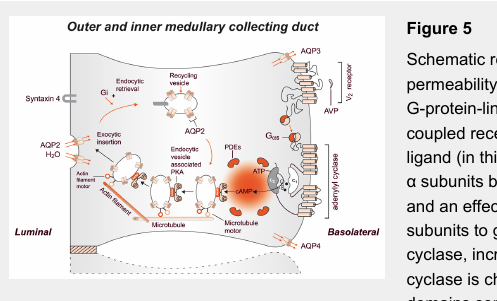
Schematic representation of the effect of vasopressin (AVP) to increase water permeability in the principal cells of the collecting duct. AVP is bound to the V 2 receptor (a G-protein-linked receptor) on the basolateral membrane. The basic process of G-protein- coupled receptor signalling consists of three steps: a hepta-helical receptor that detects a ligand (in this case, AVP) in the extracellular milieu, a G-protein (G αs ) that dissociates into α subunits bound to GTP and βγ subunits after interaction with the ligand-bound receptor, and an effector (in this case, adenylyl cyclase) that interacts with dissociated G-protein subunits to generate small-molecule second messengers. AVP activates adenylyl cyclase, increasing the intracellular concentration of cAMP. The topology of adenylyl cyclase is characterised by two tandem repeats of six hydrophobic transmembrane domains separated by a large cytoplasmic loop and terminates in a large intracellular tail. The dimeric structure (C 1 and C 2 ) of the catalytic domains is represented. Conversion of ATP to cAMP takes place at the dimer interface. Two aspartate residues (in C 1 ) coordinate two metal co-factors (Mg 2+ or Mn 2+ represented here as two small black circles), which enable the catalytic function of the enzyme (305). Adenosine is shown as an open circle and the three phosphate groups (ATP) are shown as smaller